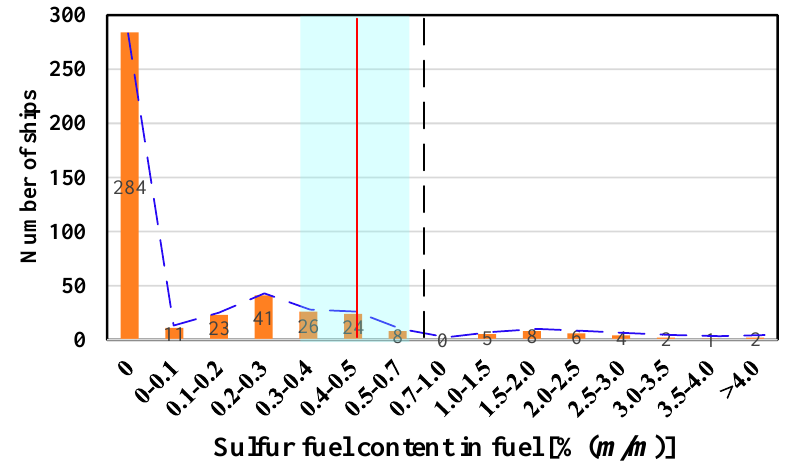
FSC of 445 measured ships. The blue dotted line represents the FSC distribution trend of all measured ships, the red line represents the limit of 0.5% ( m / m ), and the shaded area